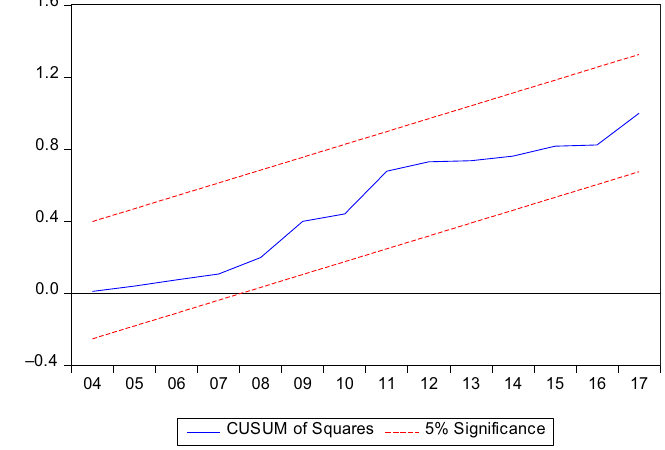
Figure 7. Plot of CUSUM of sq.